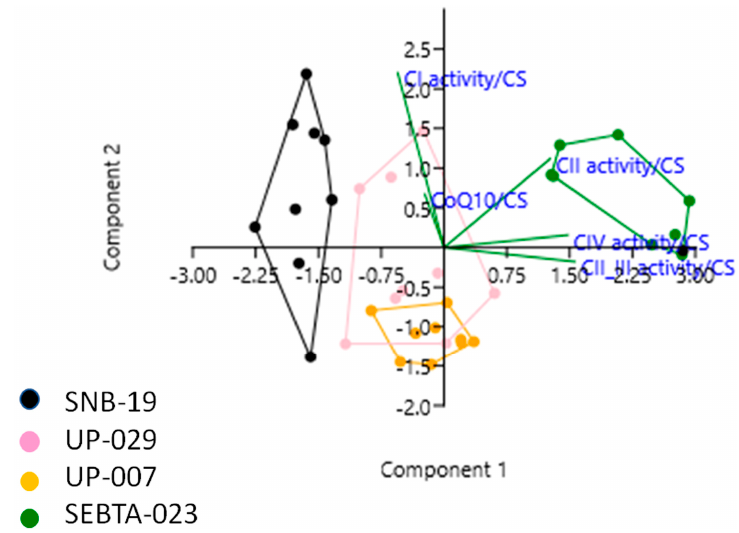
Figure 3. Principal Component Analysis (PCA) plot showing the multivariate variation among four cell lines examined in terms of their complex I, II, II_III and IV activities, and CoQ10 levels (expressed relative to citrate synthase (CS) activity in each case). Vectors (green lines) indicate the direction and power of each complex activity dataset relative to the overall distribution. Coloured dots delineate the four cell lines. The first two principal axes shown explained 78% of the variance observed among the data.